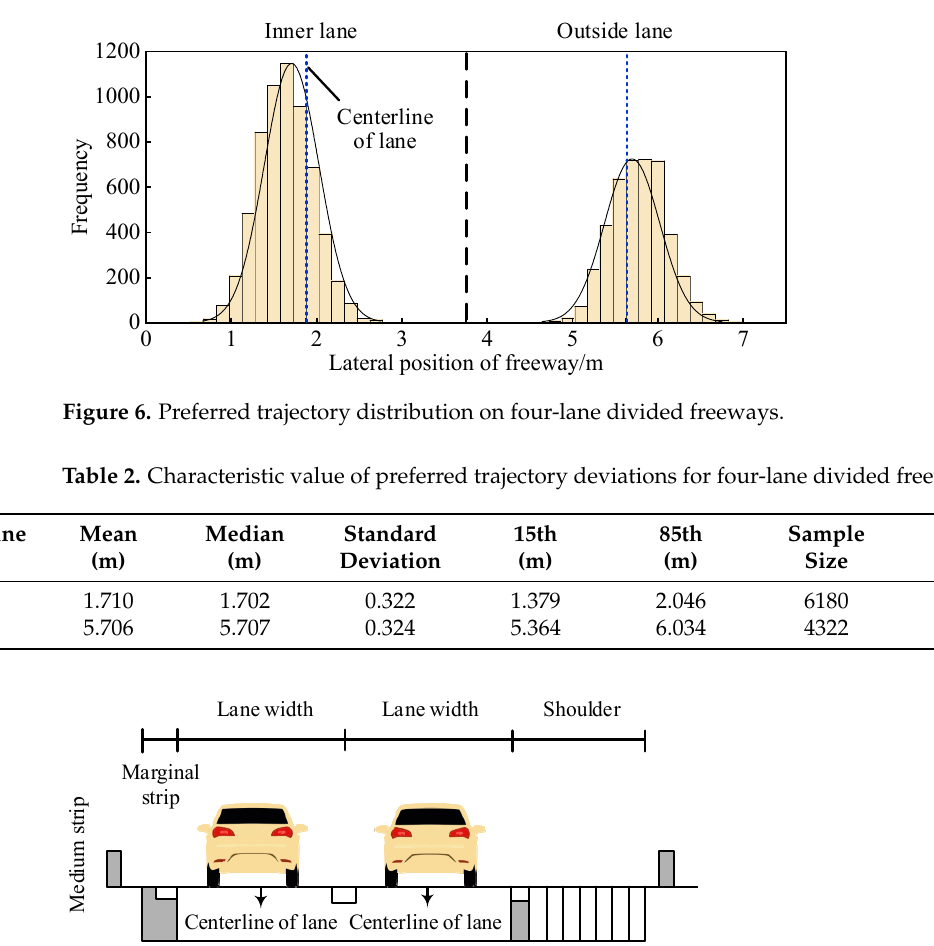
Figure 7. Illustration of the preferred trajectory preference position profile on four-lane freeways. The preferred trajectory deviations of the six-lane divided freeways are depicted in Figure 8 and Table 3. The mean values of the preferred trajectory deviations from the inner lane to the outside lane are 1.423, 5.185, and 9.175 m, respectively, indicating left, left, and right deviations. Figure 9 characterizes the lateral position preference of the vehicle within driving state, the preferred trajectory of the vehicle in the inner lane and outside lane tends to move to the side of roadway edge line, with the behavior of riding on the markings and shoulders. The preferred trajectory of the middle lane tends to stay away from the side of right lane dividing line. This can be explained by the presence of marginal strips and shoulders on both sides of the lane, which provide lateral safety clearance and extra space for vehicles in the lane, and the deviation position keeps a larger distance between the parallel vehicles in the same direction, which is conducive to reducing the driver’s psychological load. In contrast, the vehicles moving in the middle lane need to be parallel with the trucks in the outside lane. Due to the trucks’ large body size and large mass, the drivers perceive a greater safety risk than cars, so they will adjust the vehicle’s position to maintain a wider distance from the heavy vehicles in the outside